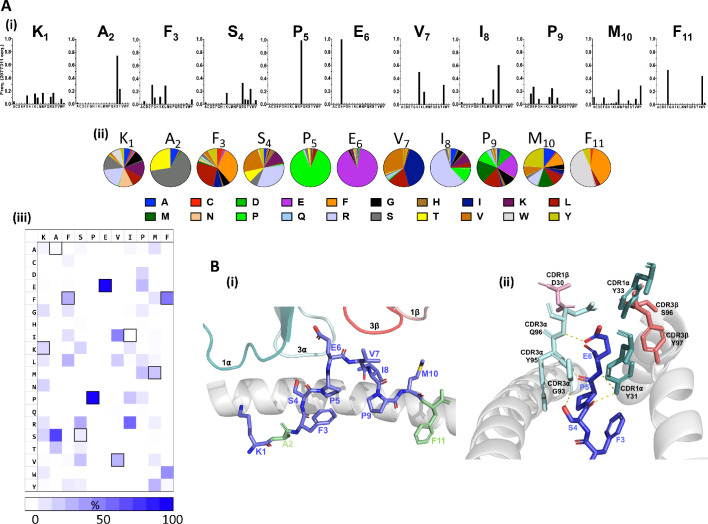
Fixation of specific peptide amino acids residues following Round 3 AGA1 TCR–mediated selection.(A) Amino acid enrichment along the length of AGA1 TCR selected 11mer peptides are illustrated (i) in bar chart format for approximately 2.0 × 106 selected peptide sequences, with individual amino acid enrichment at each position of the 11mer peptide represented on the X-axis and sequence frequency on the Y-axis. K1, A2, F3 refers to amino acid positions 1, 2, 3, etc, of the HIV KF11 epitope which is included for reference. Enrichment data for pre-(naïve) and post-AGA1 TCR selected peptides from all libraries are provided in Figure 2—figure supplement 1). (ii) The top 1000 peptide sequences are reported in pie-chart format, with the original KF11 (KAFSPEVIPMF) peptide amino acids included above the relevant pie-charts for reference. K1, A2, F3 refers to amino acid positions 1, 2, 3, etc, of the HIV KF11 peptide sequence. (iii) A Heat map of the entire Round 3 peptide sequence dataset (~2.0×106 peptides) demonstrating the near absolute dominance of Pro and Glu at positions 5 and 6, respectively, in AGA1 TCR-selected peptide datasets. The amino acid residues corresponding to the KF11 peptide are outlined in black. Heatmap scale = 0 – 100%, 10% increments. (B) Structural overview of the primary contacts formed between the AGA1 TCR and KF11 when restricted by HLA-B*57:03. (i) Slide view of the HLA-B*57:03 alpha 1 (α1) helix in cartoon form (grey), with the alpha 2 (α2) helix removed for clarity. The peptide is depicted in stick format (blue) with the KF11 position 2 Ala (A2) and Position 11 Phe (F11) anchor resides highlighted in green. The TCR CDR1α (deep teal), CDR3α (pale cyan), CDR3β (deep salmon) and CDR1β (light pink) loops that form the main contacts with HLA-B*57:03-KF11 are illustrated. (ii) Barrel view of HLA-B*57:03-KF11, oriented from the peptide’s N terminus, with HLA-B*57:03 α1 and α2 helices display in cartoon format (grey) and KF11 amino acids 3–6 illustrated in stick format (blue). The remainder of the KF11 peptide sequence is omitted for clarity. The primary polar contacts (~3 ångströms (Å)) between TCR CDR1α (deep teal) and CDR3α (pale cyan) amino acids and the KF11 peptide at positions 4 to 6 are illustrated (yellow dash lines). CDR1β residue D30 (light pink) and CDR3β amino acids S96 and Y97 (deep salmon) that reportedly form weaker peptides mediated contacts are also displayed. TCR amino acids positions are number according to Arden nomenclature (see Ref 37). Structural images were generated in PyMOL four using the Protein Data Bank coordinates 2YPL.
Figure 2—source data 1.All Round 3 AGA1 TCR recovered library peptide amino acid frequencies.

Figure 2—source data 2.Top 1000 Round 3 AGA1 TCR recovered library peptide amino acid frequencies.

Figure 2—source data 3.Heatmap of all Round 3 AGA1 TCR recovered library peptides.